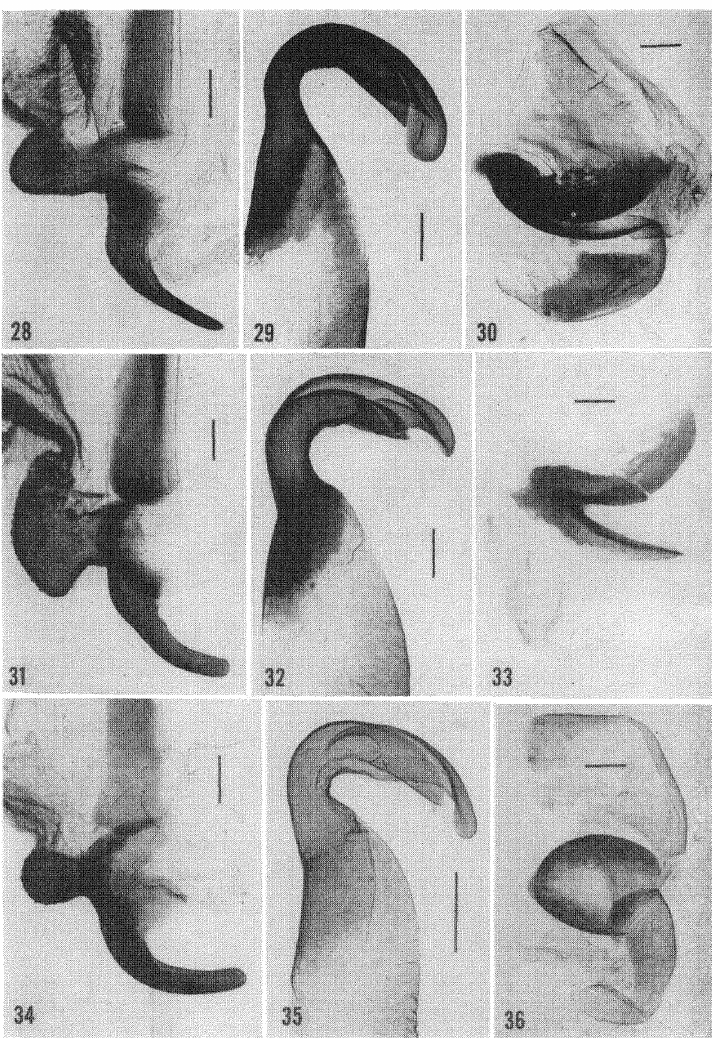
Figures 28-36. Male genital phallomeres of Perisphaeria spp. 28-30. (1421 L). P. stylifera (from shown in Fig. 7). 31-33. (161 ANSP). P. stylifera (from shown in Fig. 8). 34-36. (1423 L). P. astera (from shown in Fig. 9). (scale-- 0.2